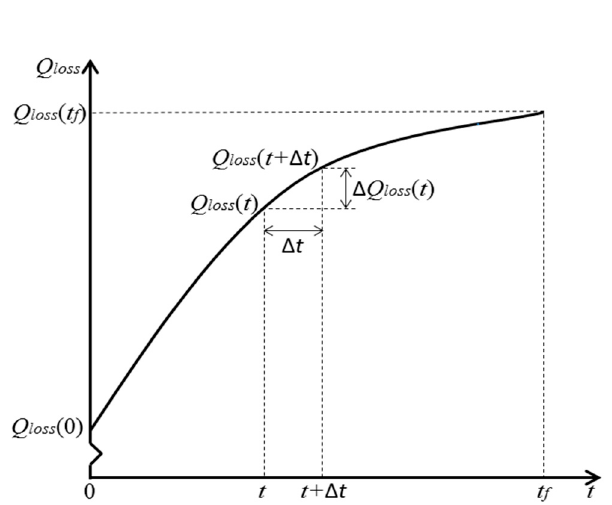
Figure 1. The variation tendency of a battery capacity loss during actual operating conditions.